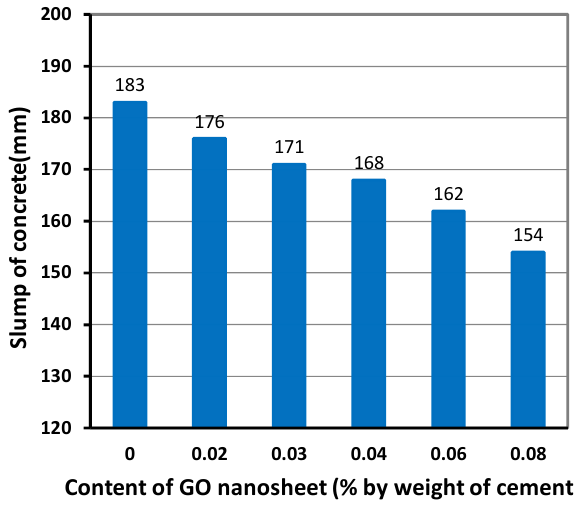
Figure 3. Slump of